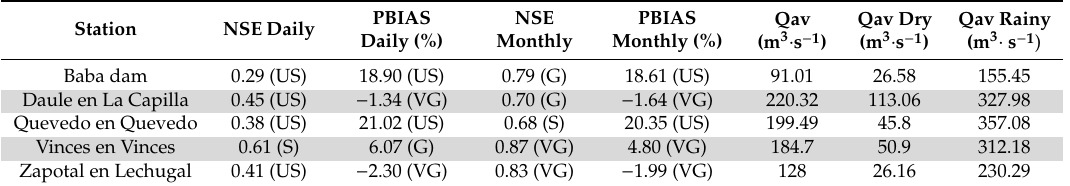
Table 3. Evaluation statistics with model performance assessment according to Moriasi et al. [82] and average registered streamflows (Qav, whole period; dry, dry season; rainy, rainy season) for the validation period (2001–2009). The stations for which manual calibration was done are indicated in grey. NSE, Nash–Sutcli ff e e ffi ciency (Equation (2)); PBIAS, percent bias (Equation (3)); VG, very